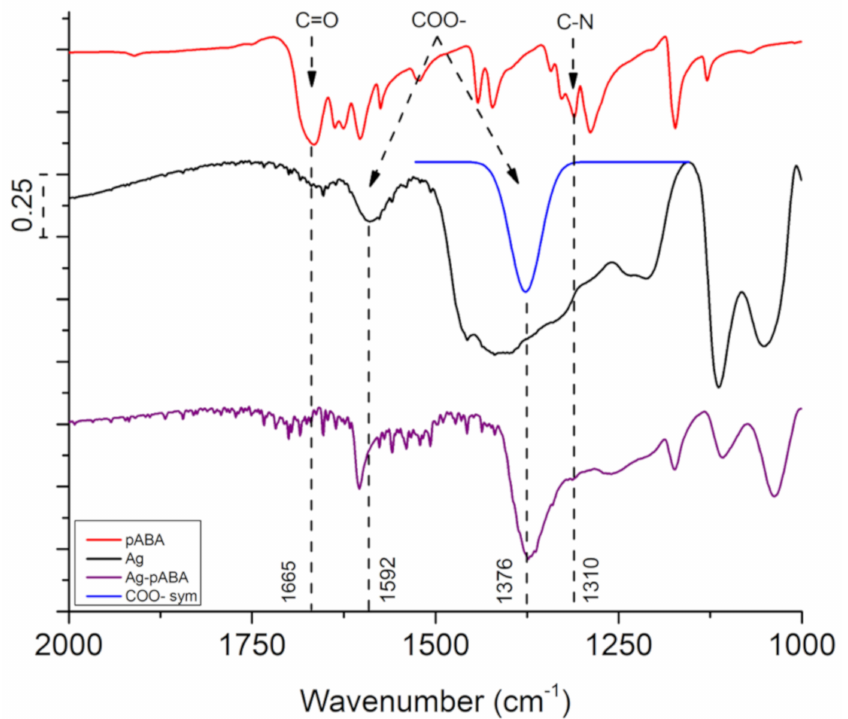
Figure 3. Fourier-transformed infrared (FTIR) spectra of pABA (red trace), Ag NPs (black trace), and Ag-pABA (purple trace). The fit peak (blue trace) was obtained from deconvolution, showing COO—symmetric